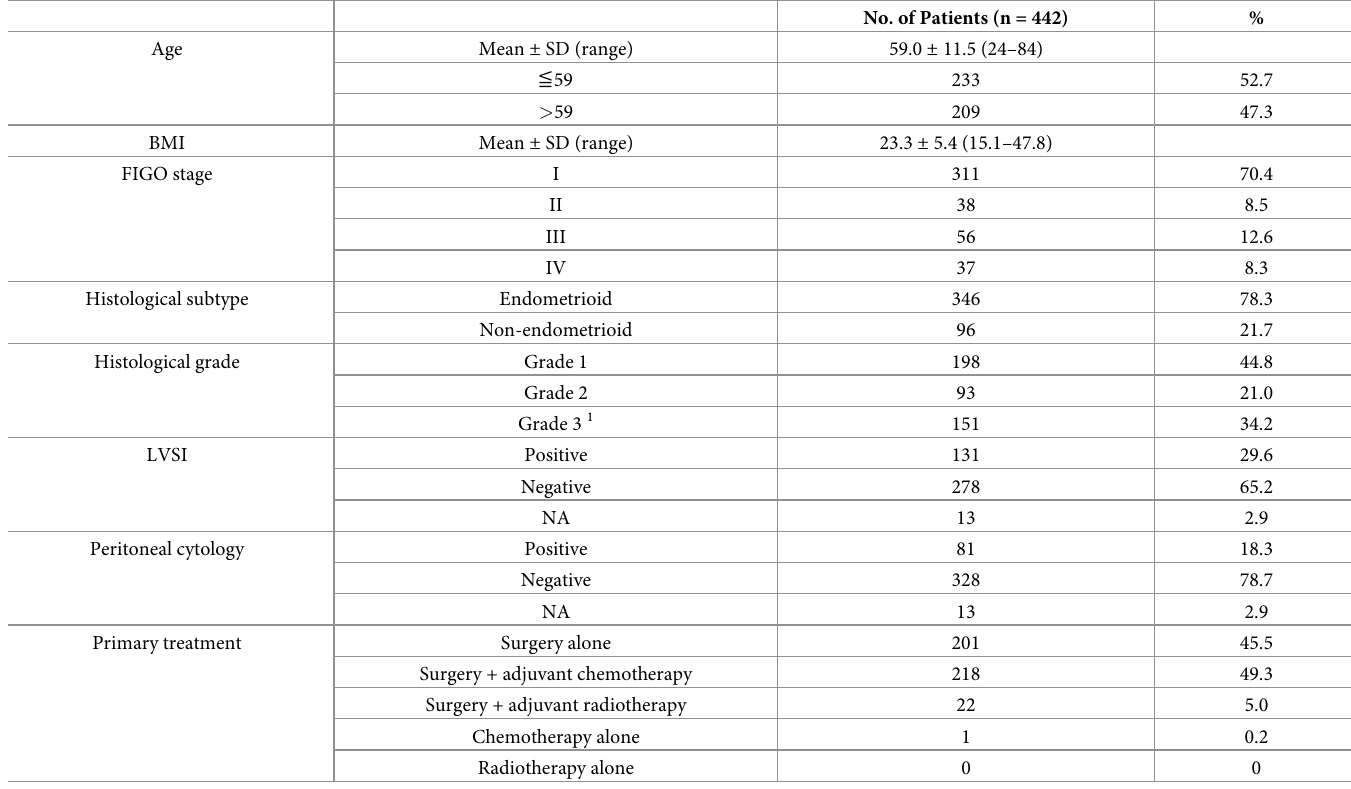
Table 1. Clinicopathological characteristics of patients with endometrial